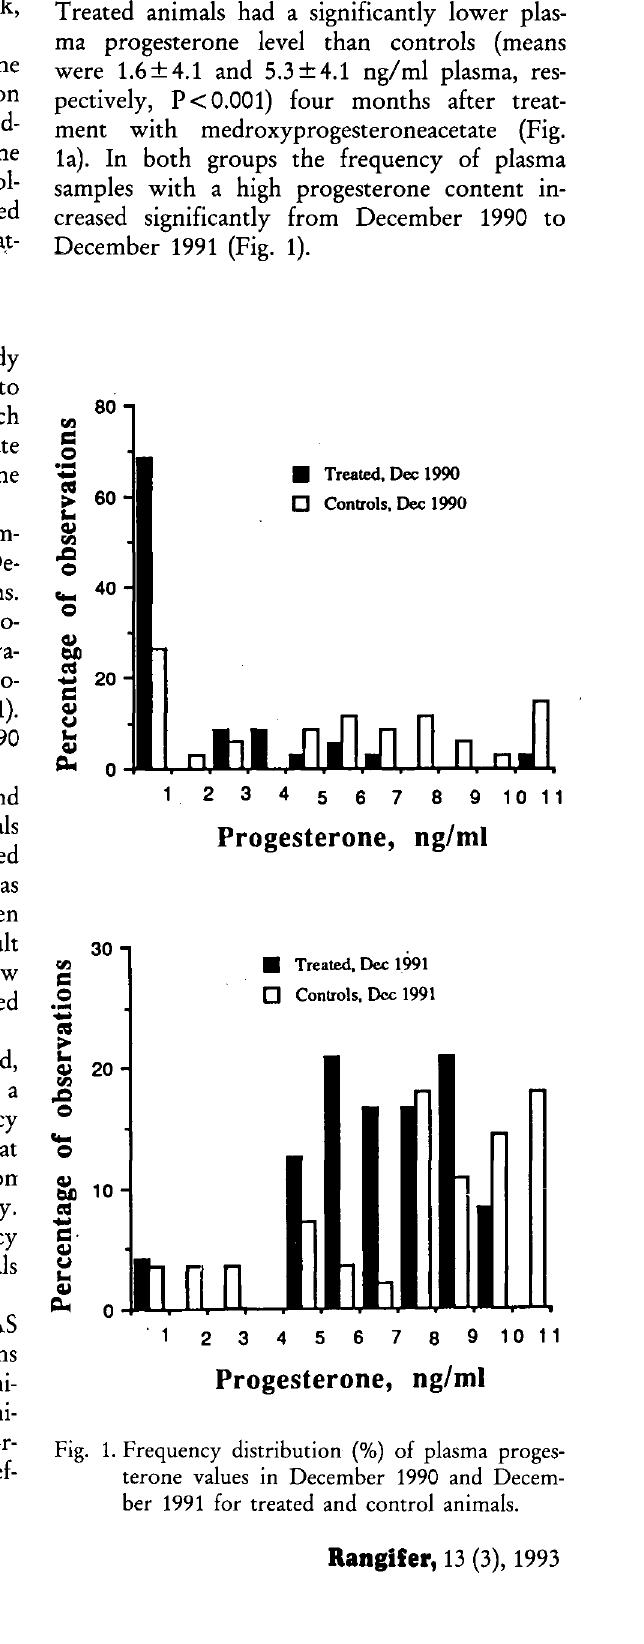
Fig. 1. Frequency distribution (%) of plasma proges terone values in December 1990 and Decem ber 1991 for treated and control